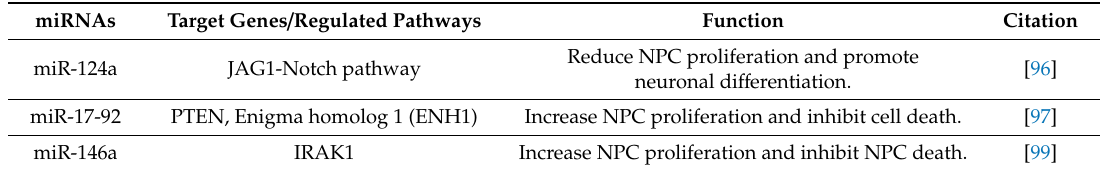
Table 1. MiRNAs and the regulation of neurogenesis after